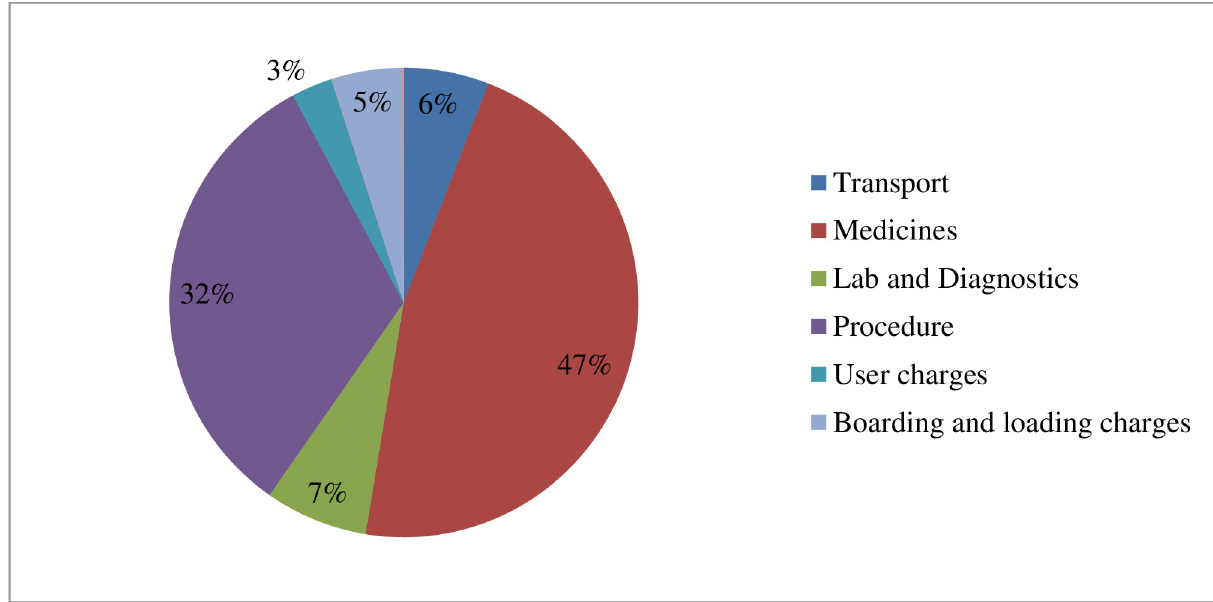
Fig 2. Distribution of out-of-pocket expenditure for injury-related